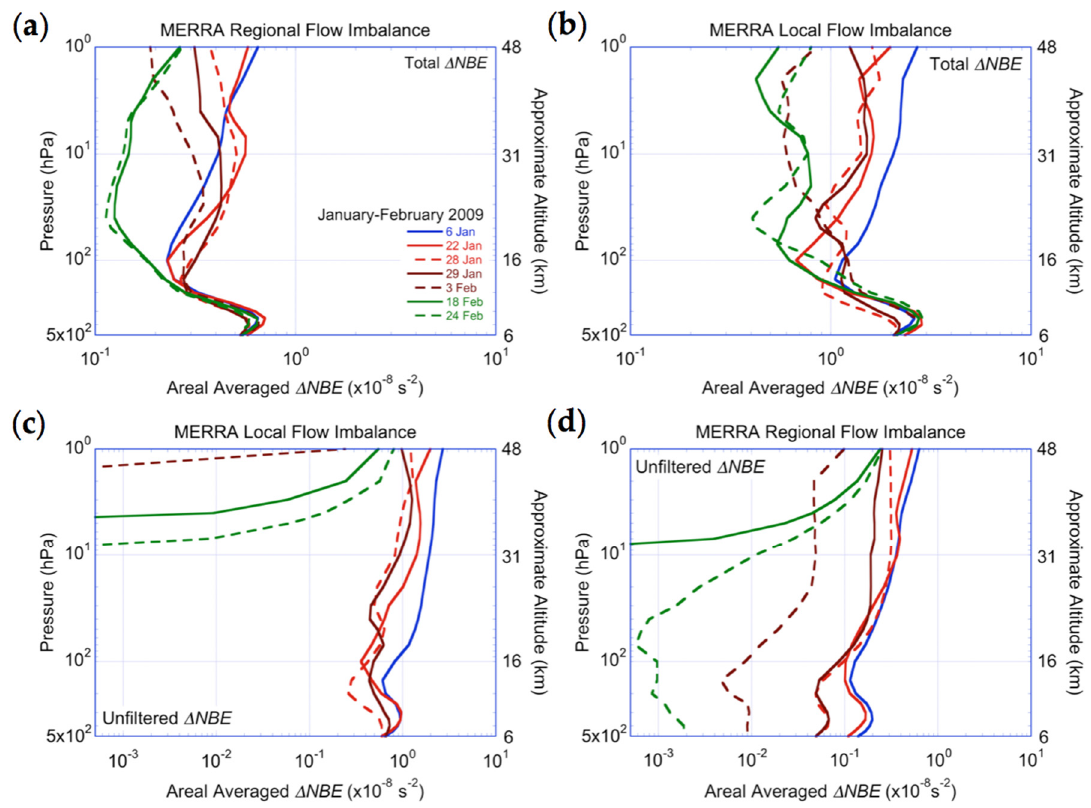
Figure 11. MERRA-derived ∆ NBE profiles for the seven nights in Figure 5. ( a ) Areal average of total ∆ NBE poleward of 50 ◦ N; ( b ) areal average of total ∆ NBE over the 800 km in radius circle centered on Chatanika; ( c ) areal average of unfiltered ∆ NBE poleward of 50 ◦ N; ( d ) areal average of unfiltered ∆ NBE over the 800 km in radius circle centered on Chatanika.